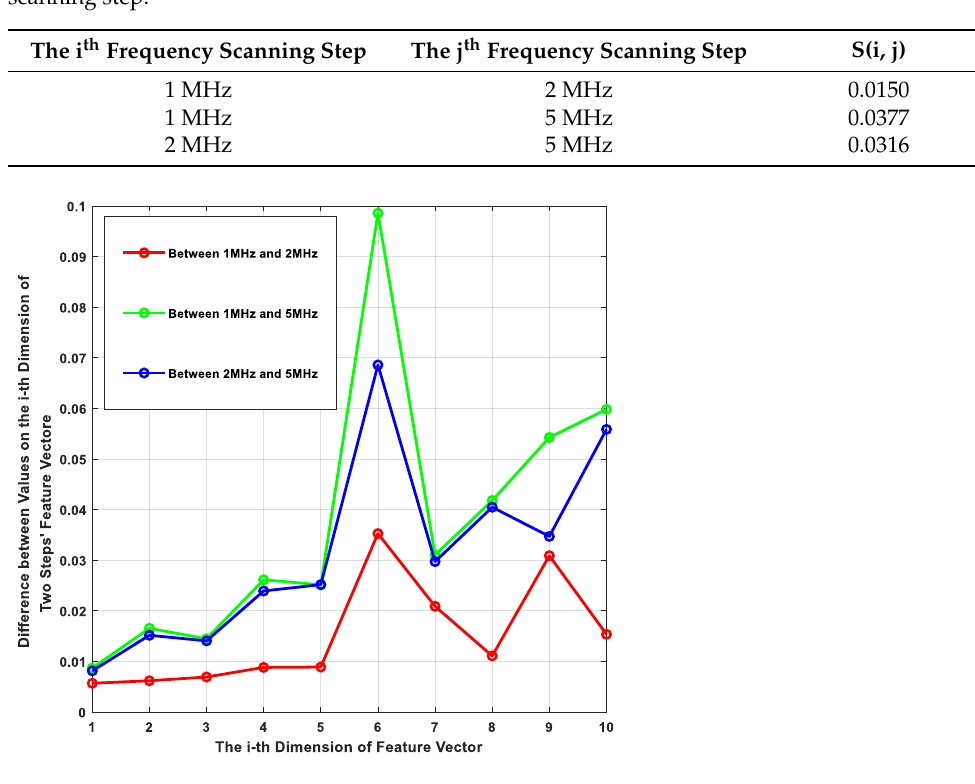
Figure 8. Results of vector subtraction between 10-dimensional Feature Vectors of different steps are visually shown. The smaller the magnitude of vector subtraction, the more similar the two feature vectors of different steps.